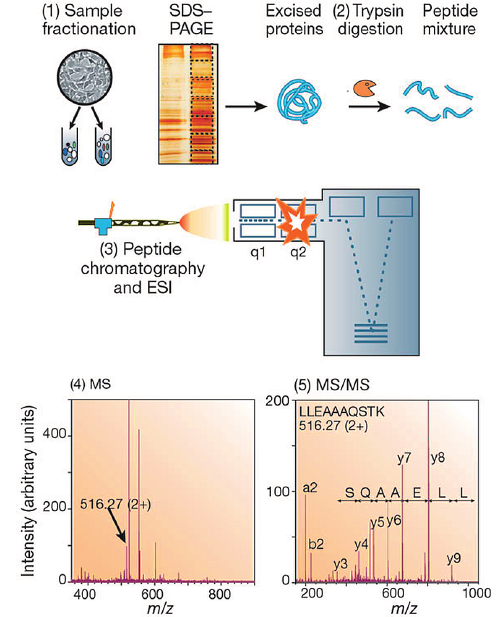
Figure 2. Typical workflow for gel-based mass spectrometry analysis. The gel is used to separate whole protein in one or two dimensions. After destaining, the proteins are excised from the gel and subjected to enzymatic proteolysis. Peptides can then be analyzed via mass spectrometry. Figure adapted from Aebersold et al. (2003)